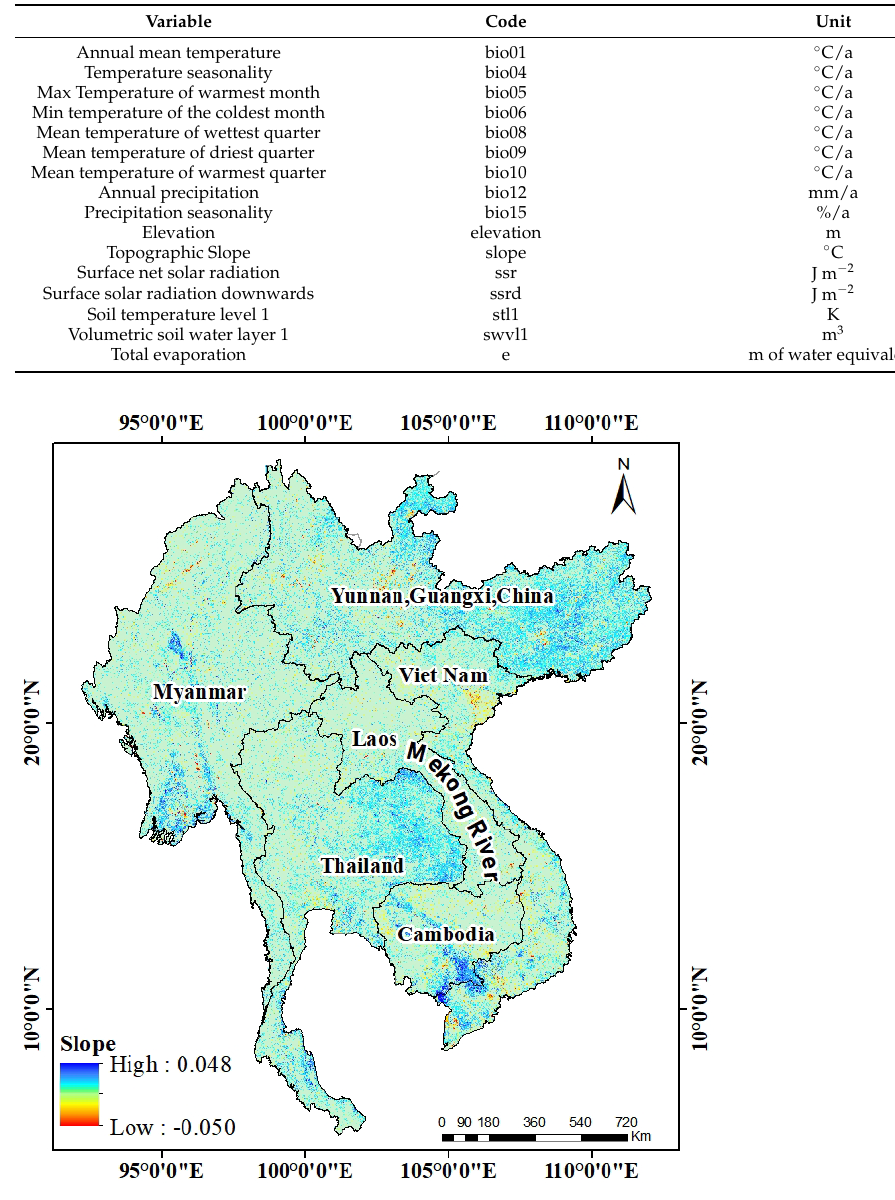
Figure A1. Map of the monotonic trend slope in GMS.